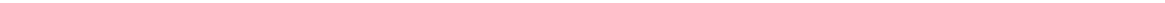
Fig. 6 Ndst1 is necessary and suf fi cient for distribution and signaling of Wnt8. a Effects of ndst1 overexpression on mV-Wnt8 accumulation. b Effects of ndst1 overexpression on endogenous Wnt8 in the VMZ. mRNAs of ndst1 and mRFP were coinjected into the ventral region of a blastomere at the 4-cell stage. Dashed line, boundary of the tracer-positive cells. Graph, quanti fi cation of endogenous Wnt8 at cell boundaries (mean ± s.e.m.). Number of the measured cell boundaries were as indicated. c Effects of ndst1 knockdown on endogenous Wnt8 in the VMZ. MO and FITC-dextran were coinjected into the ventral region of a blastomere of 4-cell stage embryos. Graphs, quanti fi cation of endogenous Wnt8 at cell boundaries (mean ± s.e.m.). The number of the measured cell boundaries (n) was as indicated. d Schema for overexpression and knockdown of ndst1 . A view from the animal side. wnt8-myc mRNA was injected into the animal pole region. ndst1 mRNA or ndst1 MO was injected as indicated. TR-Dx, Texas red-conjugated dextran. e – h Overexpression or knockdown of ndst1 . The number of cells with or without nuclear β -catenin staining was counted in a low Wnt activity area for overexpression ( e , f) or in a high Wnt activity area for knockdown ( g , h ). The Nnumber of the analyzed cells was as indicated ( f , h ). i – k TOP-Flash reporter assay. Graphs, mean ± s.e.m. The number of the measured pools (each pool contained three embryos) was as indicated. Xenopus embryos at stage 11.5 were analyzed. Images are a representative of at least two independent experiments. White arrowheads indicate increase or stronger signal compared to open arrowheads (the absence of open arrowheads indicates no difference). Statistical tests (all two-sided): t -test ( b , c ); Fisher ’ s exact test ( f , h ); or pairwise Wilcoxon rank sum test ( i – k , multiple comparison). Signi fi cance levels: * p < 0.05, ** p < 0.01, *** p < 0.001, NS, not signi fi cant. Amounts of mRNA (pg/embryo): mV-wnt8 , 1000; mRFP , 500; ndst1 , 500 ( a , b , e , i ), 20 ( j , k ), or 50 ( j , k ) or 3.3 ( c ); wnt8-myc , 250 ( e , g ); ecfp , 500; wnt8 , 250 ( i – k ). Amounts of MO (ng/embryo): std MO